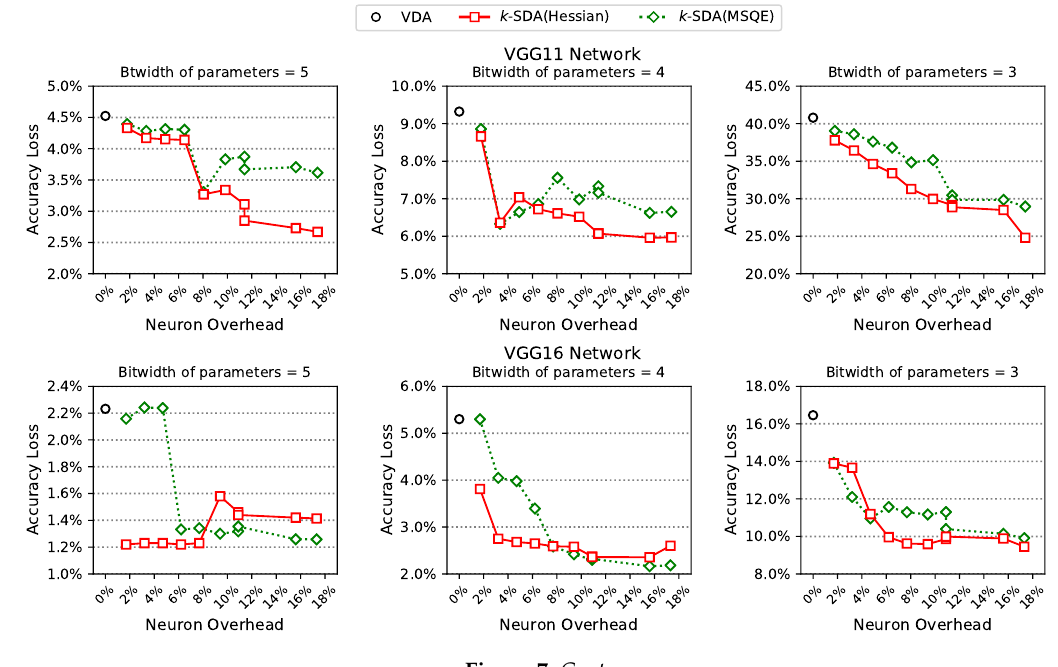
Bitwidth of parameters = 3 Figure 7. Cont